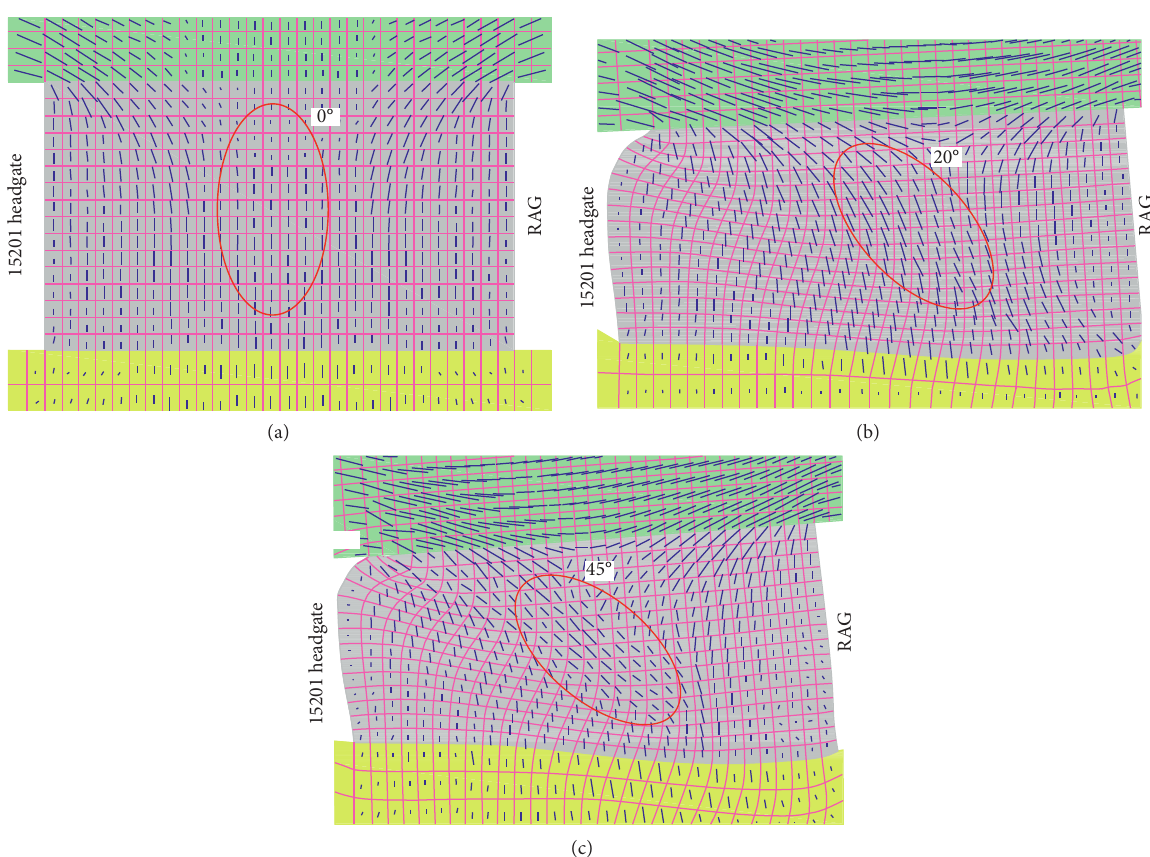
Figure 14: Change of the orientation of the maximum principal stress in the three stages (negative and positive numbers indicate the 15201 longwall face was inby and outby the site, respectively). (a) Stage A, − 10m. (b) Stage B, +80m. (c) Stage C, +150